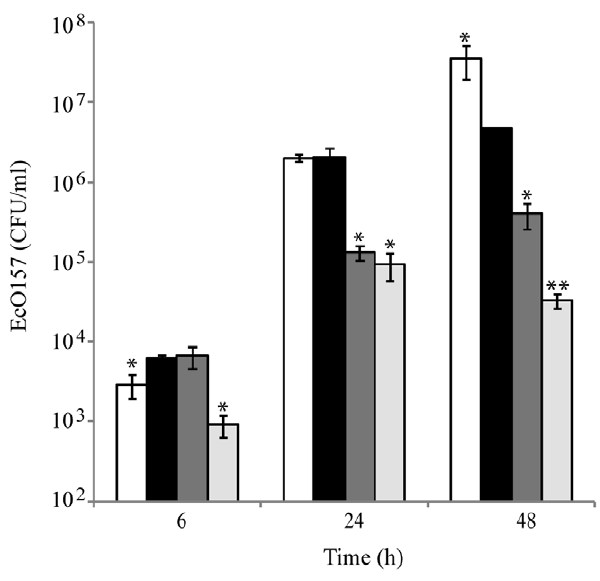
Figure 2 . Biofilm formation of EcO157 on a stainless steel surface in spinach lysates. The EcO157 biofilm population size was measured in filter-sterilized 100% spinach lysates (white columns); non-sterile 100% spinach lysates (black columns); non-sterile 5% spinach lysates (dark grey columns); and non-sterile 0.1% spinach lysates (light grey columns). Data represent the mean EcO157-biofilm population size and standard deviation of the mean in three replicate lysates. At each time point, the mean population size of EcO157 in the biofilms was compared with that in non-sterile 100% spinach lysates by ANOVA (** P , 0.01; * P , 0.05).